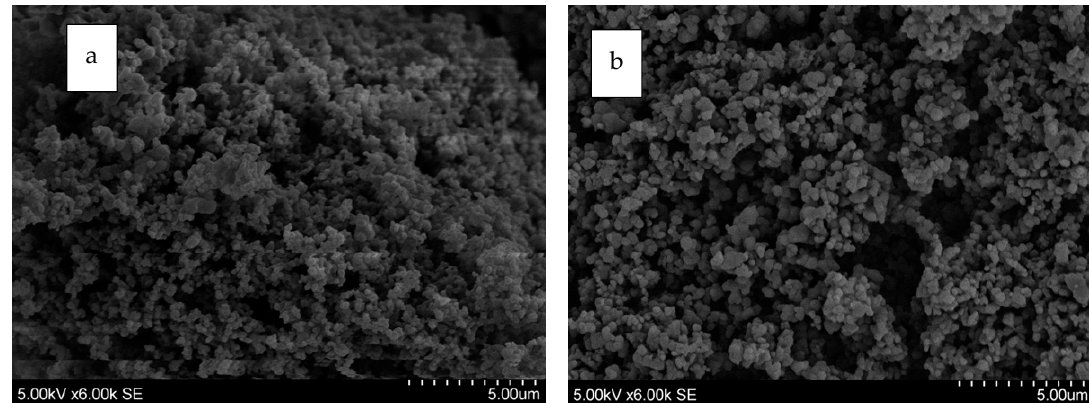
Figure 9. SEM mages: ( a ) non-imprinted 5 mol % EGDA, 3 mol % tBA; and ( b ) zinc imprinted 5 mol % EGDA, 3 mol % tBA. Both images are under 6000× magnification. Table 2. Porosity data for 3 mol % tBA Zn +2 non-imprinted and imprinted resins. 3 Mol % tBA Non-Imprinted